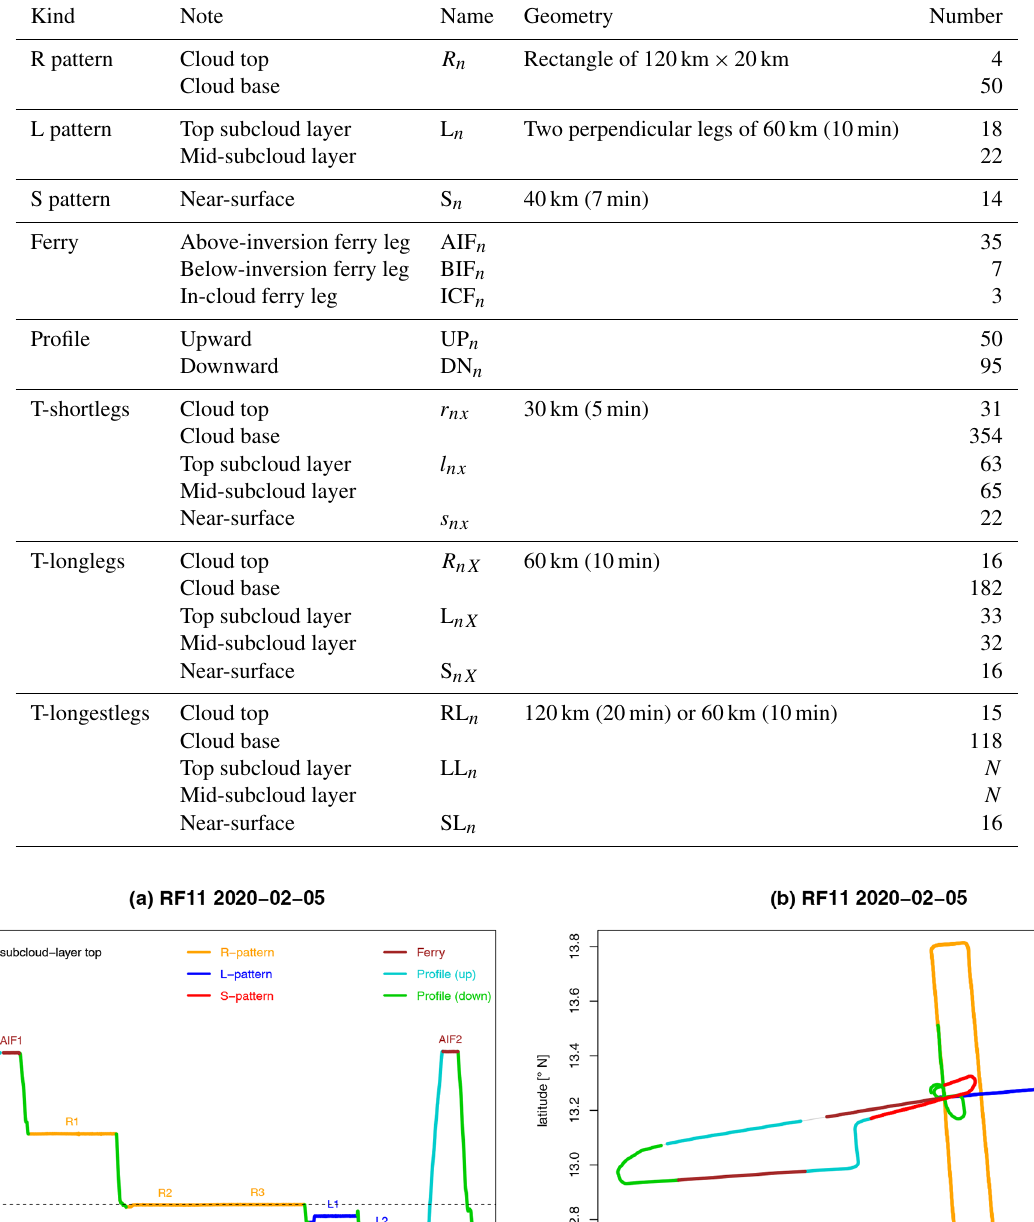
Table 2. Segmentation of the ATR flights into patterns (“kind”), flown at different levels (“note”). Each segment is associated with a “name”, where n = 1 , 2 ...N ( N being the number of patterns of the “kind” category flown during the flight); X = A, B, C.... and x = a, b ... h. See Fig. 6 for an illustration of the sub-segmentation of the patterns into T-shortlegs, T-longlegs and T-longestlegs segments. Also reported is the total number of segments in each category. This information is included in a set of YAML files (one file per flight).